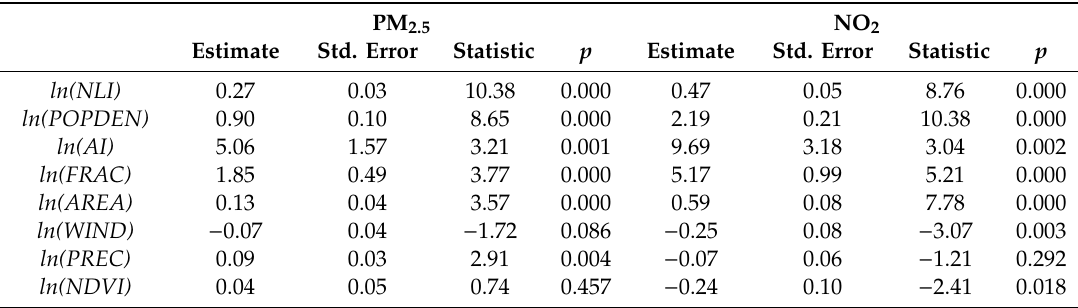
Table 3. Estimations of the FE